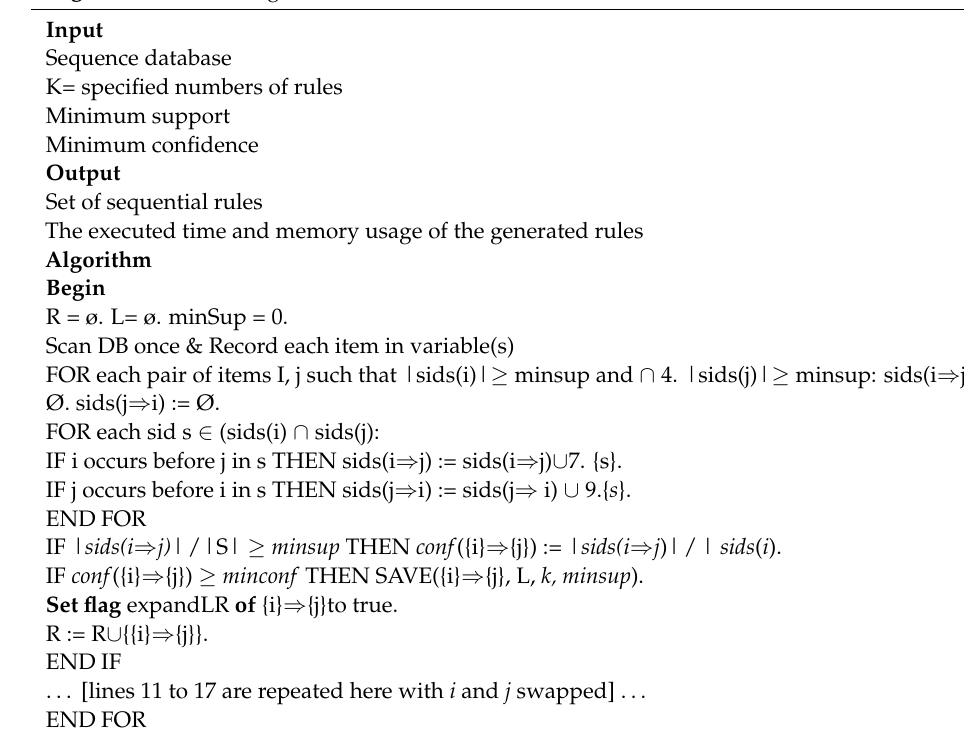
Algorithm A2 : TNS